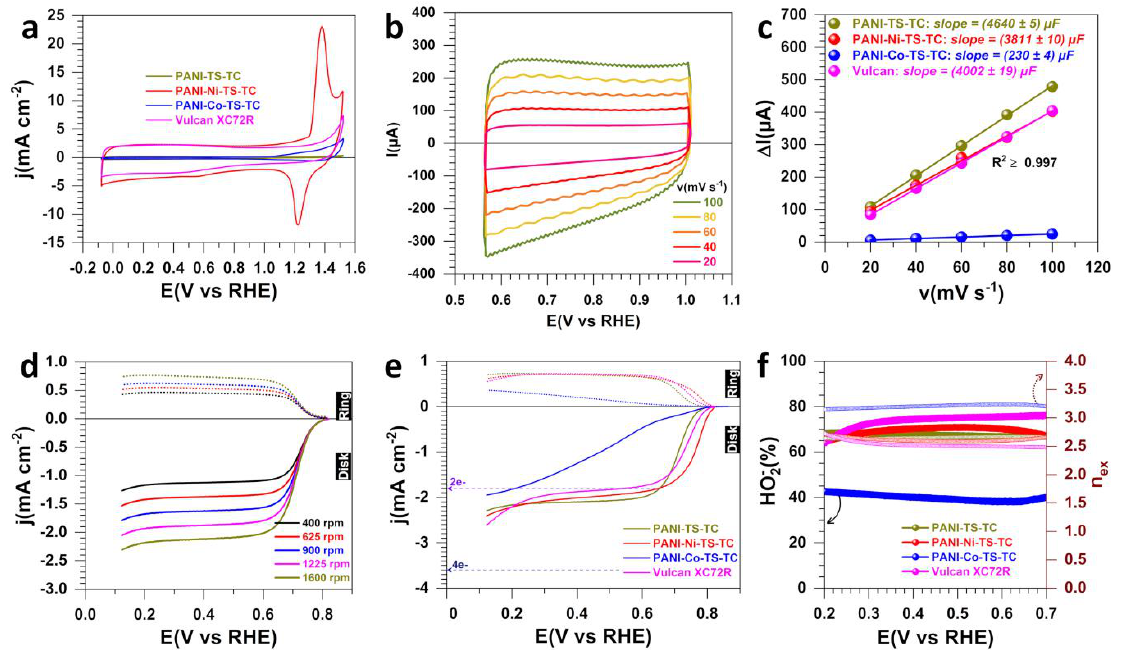
Figure 3. Electrochemical characterization for the materials obtained after polymerization (5 °C, 13 h), stabilization (air, 350 °C, 2 h) and calcination (N 2 , 900 °C, 6 h). ( a ) iR-drop uncorrected CV (N 2 -saturated 1 M KOH, 25 °C, 100 mV s −1 , 0 rpm). ( b ) iR-drop uncorrected CV of PANI-TS-TC (N 2 -saturated 1 M KOH, 25 °C, 0 rpm) for determining ECSA. ( c ) Capacitive current ( Δ I a = I a − I c ) vs. scan rate at E(V RHE ) = 0.8 (PANI-TS-TC), 0.9 (PANI-Ni-TS-TC), 0.7 (PANI-Co-TS-TC) and 1.0 (Vulcan). ( d ) iR-drop uncorrected LSV of ORR for PANI-TS-TC at different speeds of RRDE (O 2 -saturated 1 M KOH, 25 °C, 5 mV s −1 , E ring = 1.2 V RHE ). ( e ) iR-drop uncorrected LSV of ORR at RRDE (O 2 -saturated 1